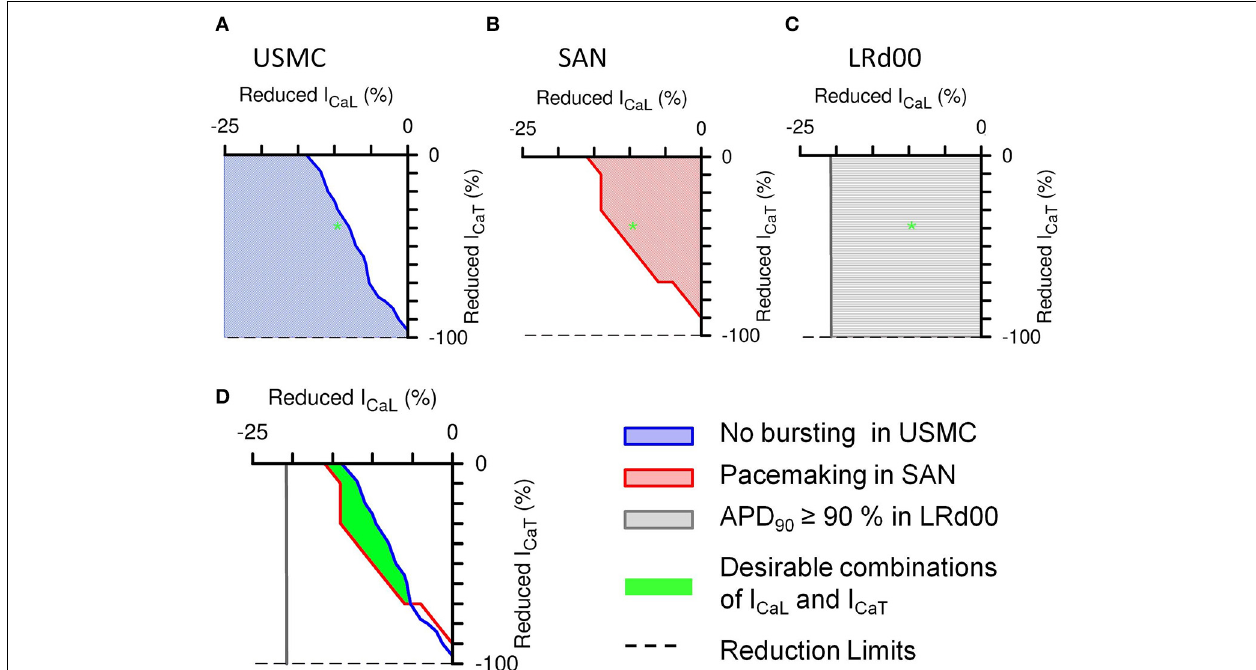
FIGURE 6 | Summarized effects of different combinations of reduced I CaL and I CaT on the APs of the three different cell types. The shaded areas in the 2-parameter maps indicate the type of AP that would be produced with the different combinations of proportionally reduced I CaL and I CaT : (A) suppressed bursting in the USMC cell model, (B) pacemaking activities in the SAN cell model, and (C) less than 10% change in the action potential duration